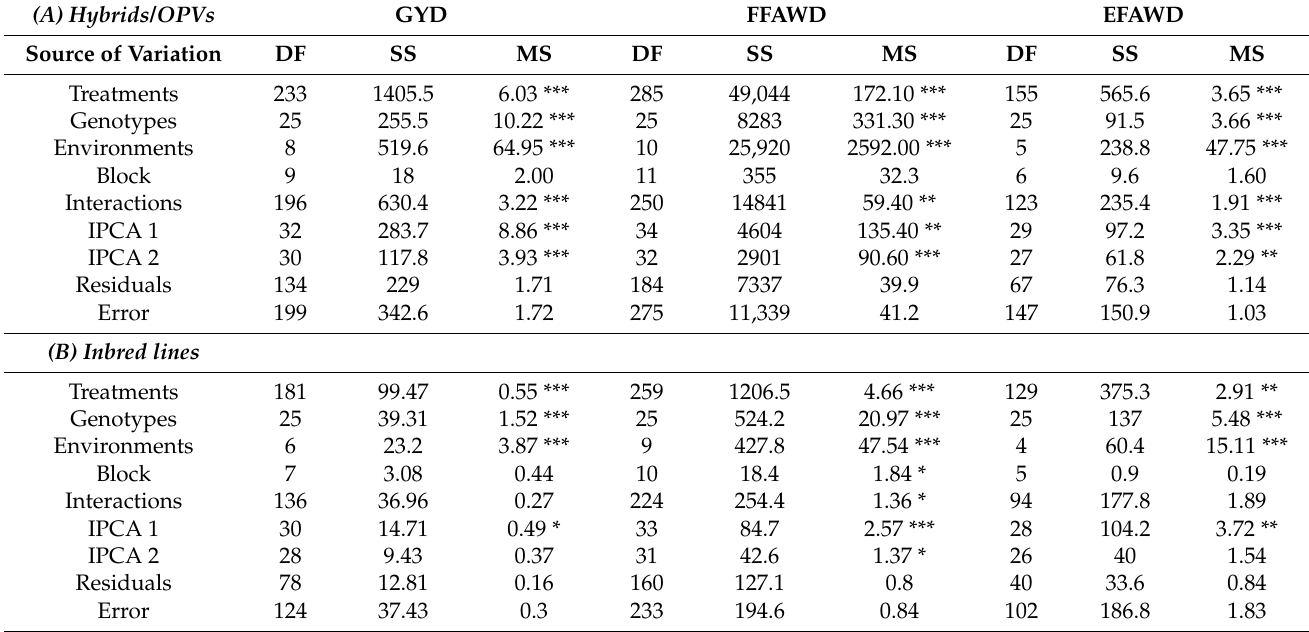
Table 3. Analysis of genotype by environment effect for grain yield, fall armyworm resistance and related traits using the AMMI model for commercial cultivars, experimental hybrids and inbred lines under natural FAW infestation sites in Zimbabwe during the 2019 and 2020 summer